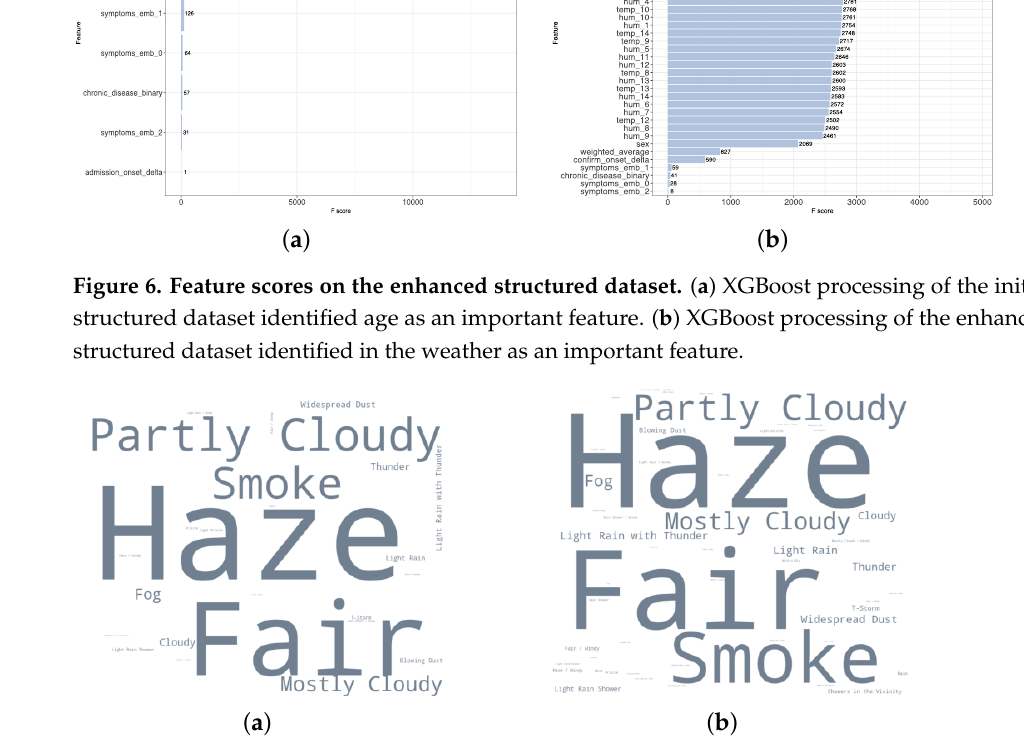
Figure 7. Textual weather description. ( a ) Word cloud visualization of the frequency of textual weather description for survivors. ( b ) Word cloud visualization of the frequency of textual weather description for